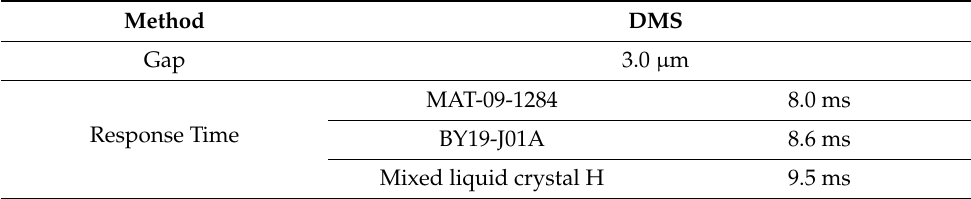
Table 7. The response time of mixed liquid crystal H.